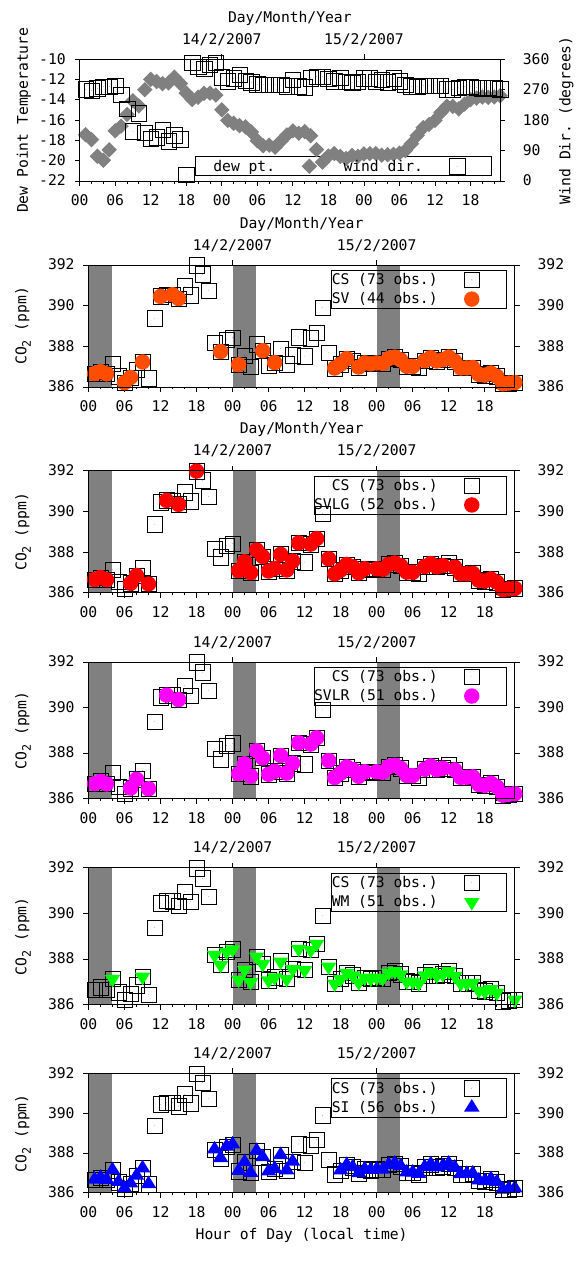
Fig. 6. A synoptic case study from NWR site (13–15 February 2007) comparing filtered subsets standardized to retain two-thirds of NWR measurements. The upper plot of meteorology data has dual vertical axes that are listed on the left and right. The num- ber of observations comprising each case study subset is listed in the legend box. The gray band locates the 00:00–04:00LT interval, which is used by some inversion model systems in place of statisti- cal filtering prior to